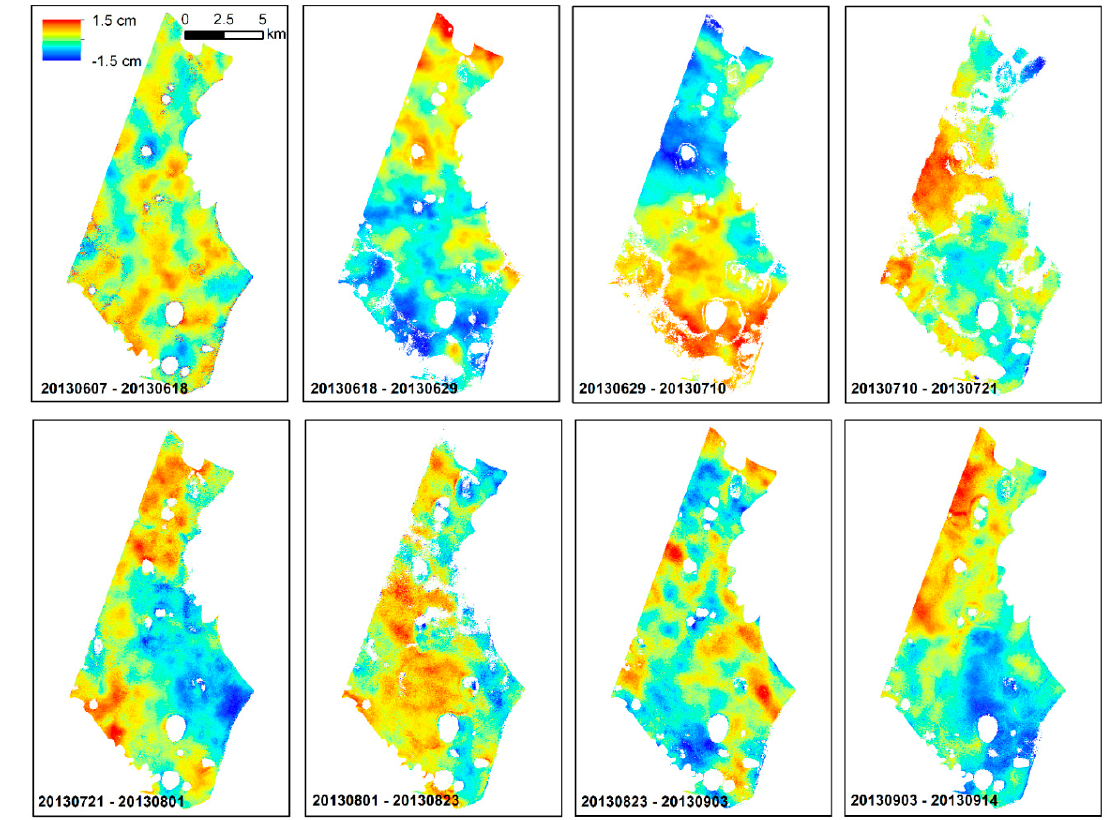
Figure A4. Georeferenced displacement maps obtained from single interferograms. Maps are clipped to match the area of the studied island. The color bar applies to all the maps. Atmospheric noise is present in all the maps.